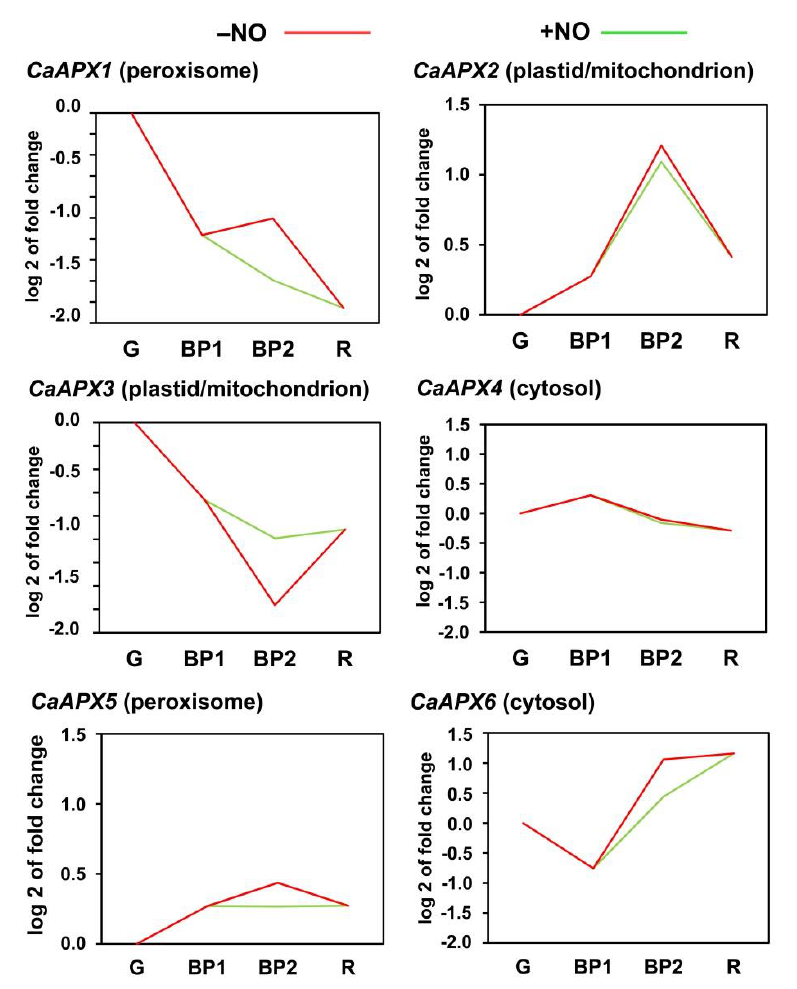
Figure 3. Time course expression analysis of six CaAPX genes (RNA-Seq). Samples of sweet pepper fruits at different ripening stages correspond to immature green (G), breaking point 1 (BP1), breaking point 2 with (green line) and without (red line) NO treatment (BP2 + NO and BP2 − NO, respectively) and ripe red (R).